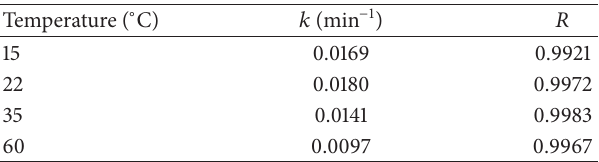
Figure 6: Effect of temperature on ultrasonicdegradation of fuchsin basic (initial dye concentration = 10 𝜇 molL −1 , ultrasonic power = 400 W, ultrasonic frequency = 25 kHz, and pH = 6.5). Table 1: Pseudo first-order rate constants of fuchsin basic degra- dations (initial dye concentration = 10 𝜇 molL − 1 , ultrasonic power = 400 W, ultrasonic frequency = 25 kHz, and pH = 6.5).